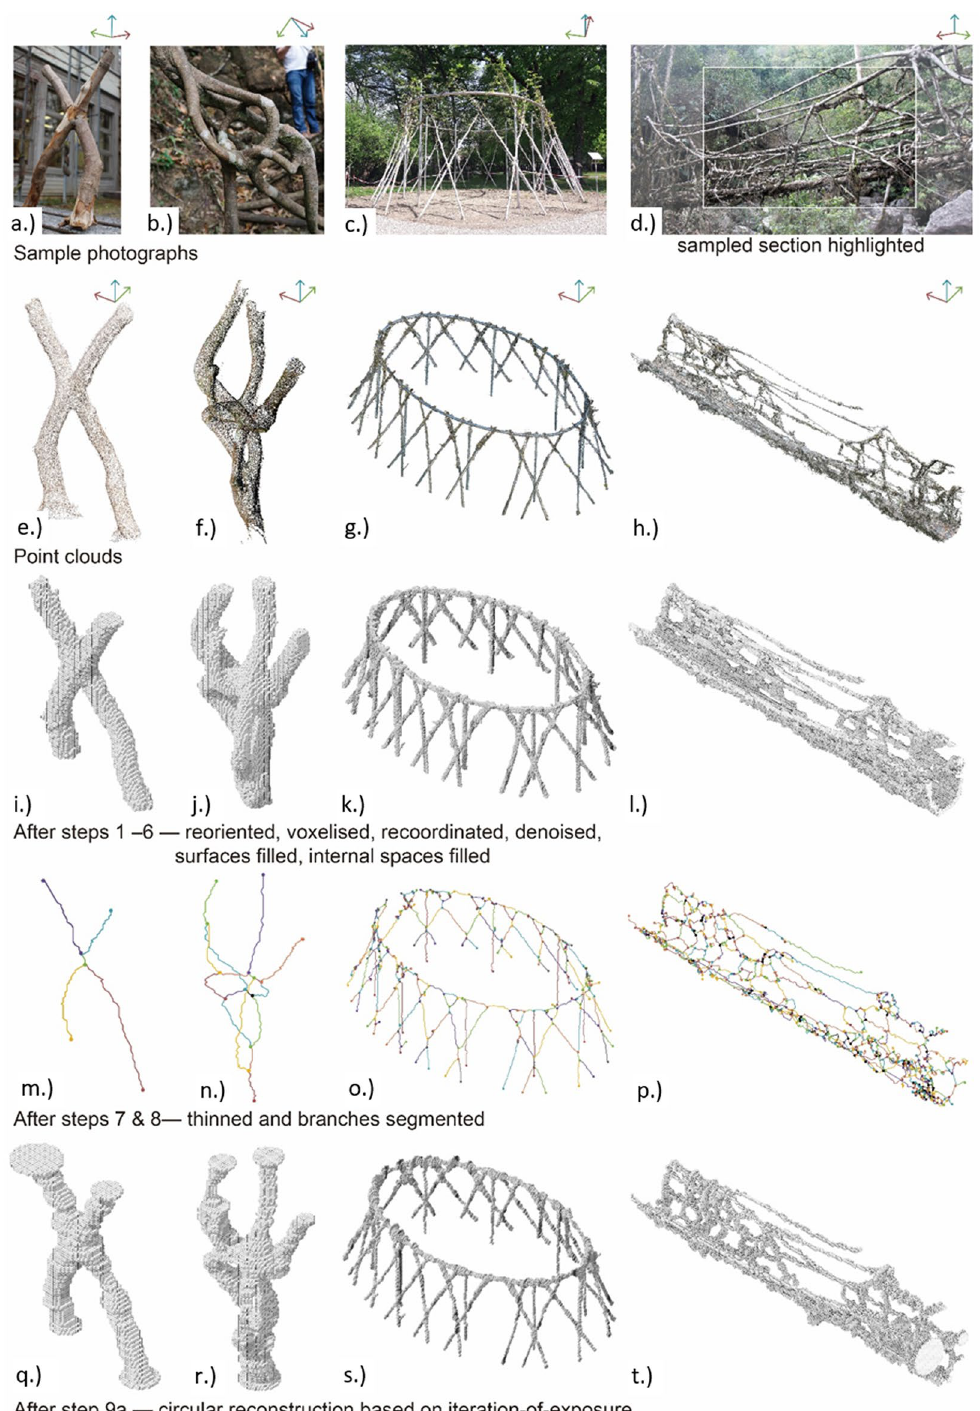
Figure 5. The Baubotanik joint, Ficus joint, Freiburg pavilion and Wah Koh La bridge as photographs ( a – d ) and corresponding point clouds ( e – h ); reoriented, voxelised model in Cartesian coordinates, denoised with any surface holes filled and the internal space filled ( i – l ); the resultant 1-voxel-thick skeleton, segmented by joint voxels ( m – p ); and circular volume reconstruction using iteration-of-exposure counts ( q – t